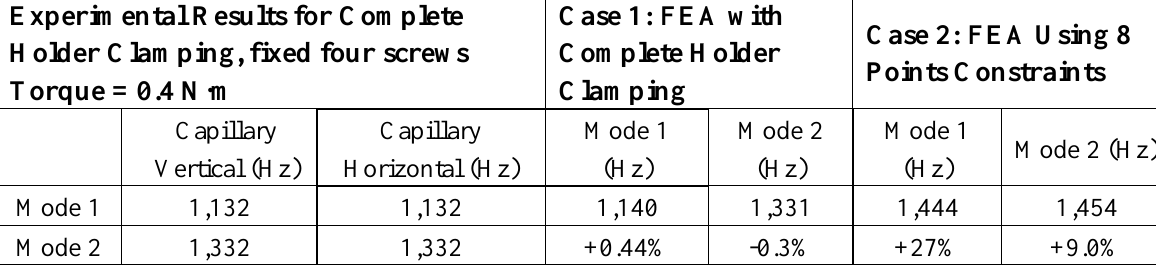
Table 3. Comparison of results for transducer with steel horn (holder diameter 13.0 mm). Experimental Results for